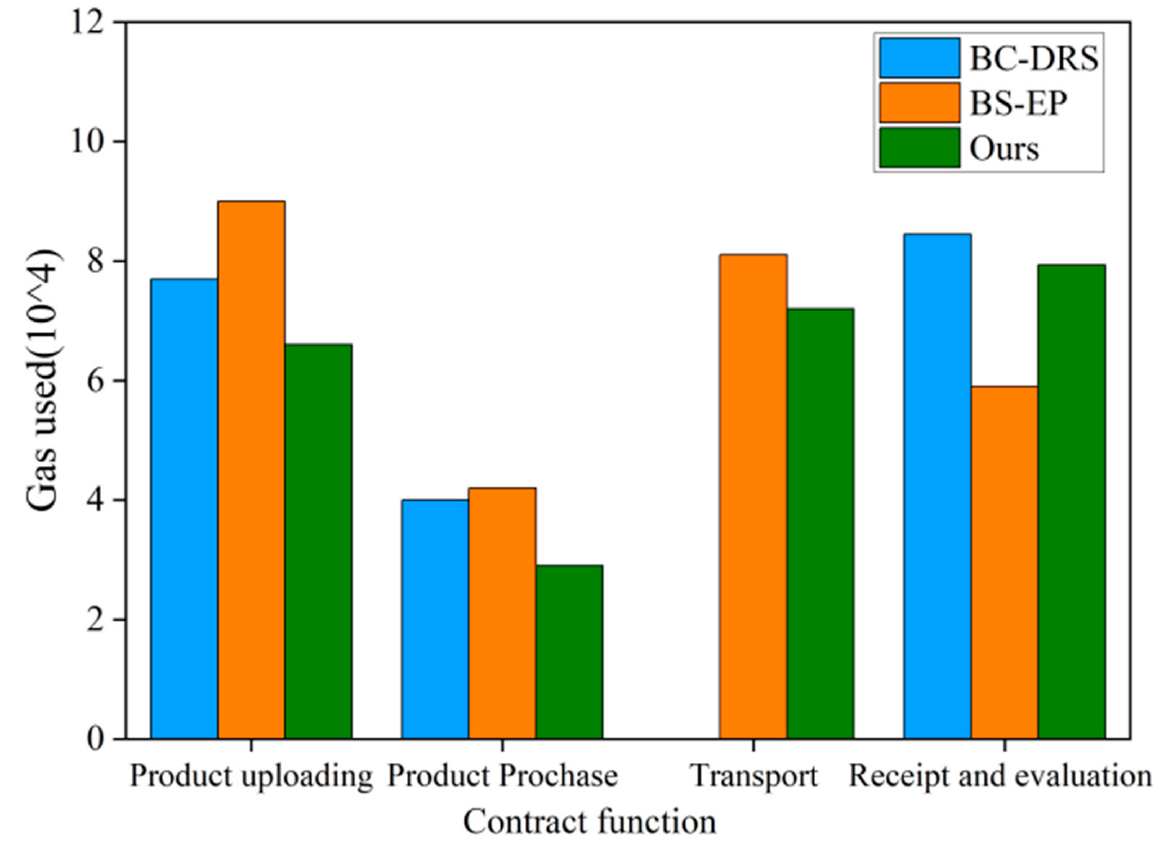
Figure 7. Comparison of gas consumption in smart contract.